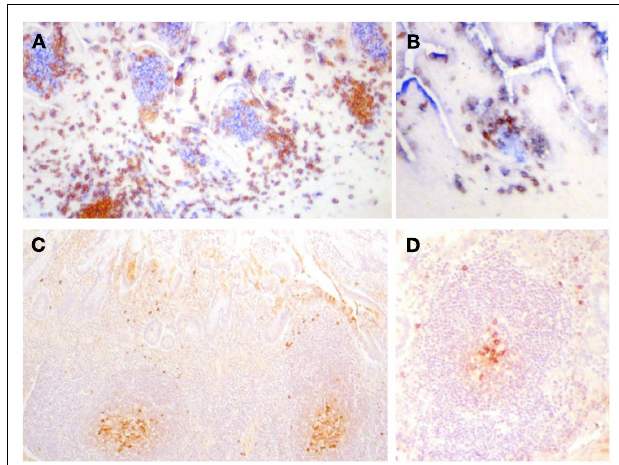
FIGURE 3 | (A,B) Frozen sections of human fetal intestine of 22weeks of gestation. (A) Is stained with CD3 (T cells in brown) and CD20 (B cells in blue). (B) Is stained for CD3 (T cells in brown) and CD5 (B cells in blue since human fetal B cells are CD5 + ). Follicles in clusters in (A) or as ILF in (B) are the same in terms of the cellular composition and stage of development. Paraffin sections of human intestine at 4days old stained for cytoplasmic IgM. (C) Illustrates a cluster of follicles in a Peyer’s patch and (D) illustrates a single follicle that could be classified as an ILF. In (C,D) , cytoplasmic IgM + cells can be identified in the germinal center and on the periphery of the follicle and they appear very similar.There was very little IgA apparent in sections of either in stained serial sections.These images demonstrate that in human ileum there is no apparent developmental difference between follicles in clusters and isolated lymphoid